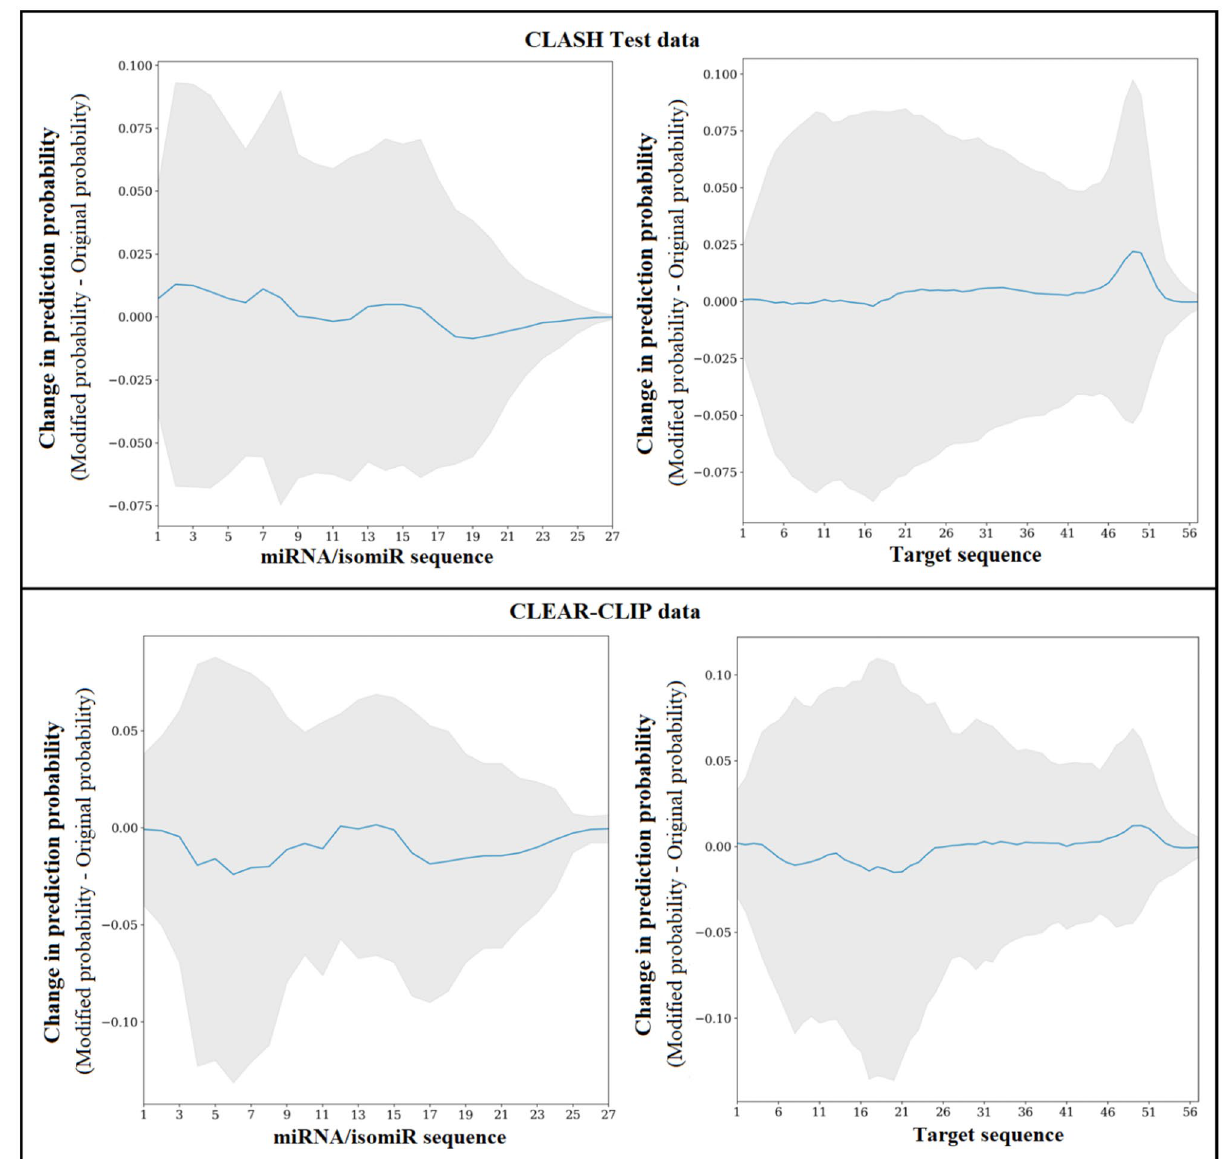
Figure 2. The changes in DMISO’s prediction probabilities with modification to different regions of the input miRNA (isomiR) and target